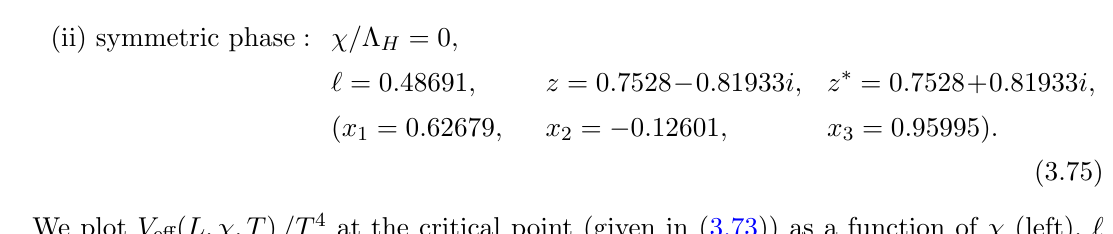
Figure 12 . The potential V e(cid:11) ( L; (cid:31); T ) =T 4 around T c; 5 = (cid:3) H = 3 : 615 as a function of (cid:31) (left), ‘ (center) and p (right) on the two di(cid:11)erent lines c 0 in (3.69) and (3.70).